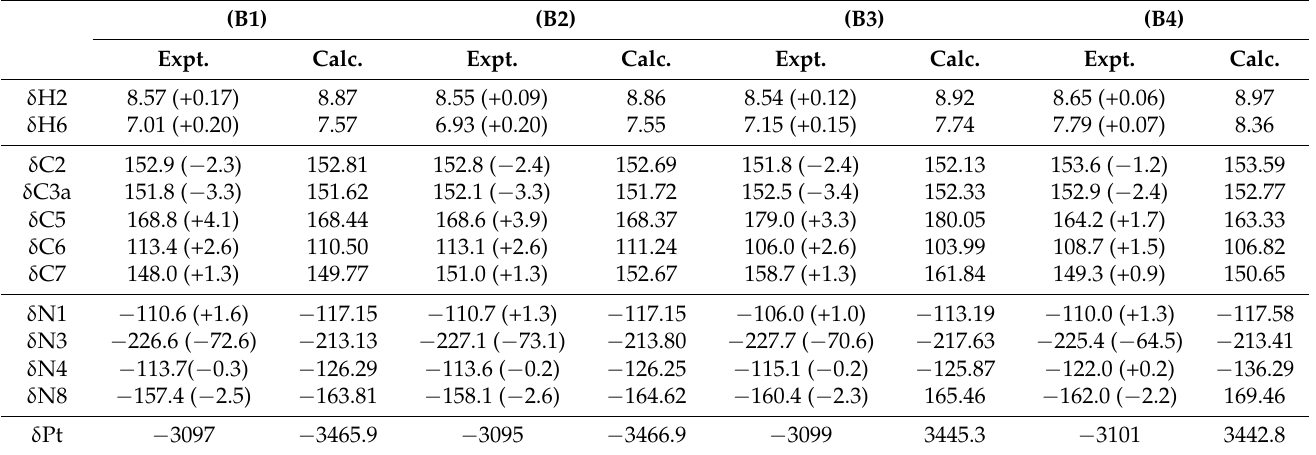
Table 4. Experimental and calculated 1 H, 13 C, 15 N, and 195 Pt NMR chemical shifts for selected atoms of the platinum(II) complexes with diphenyl sulfoxide